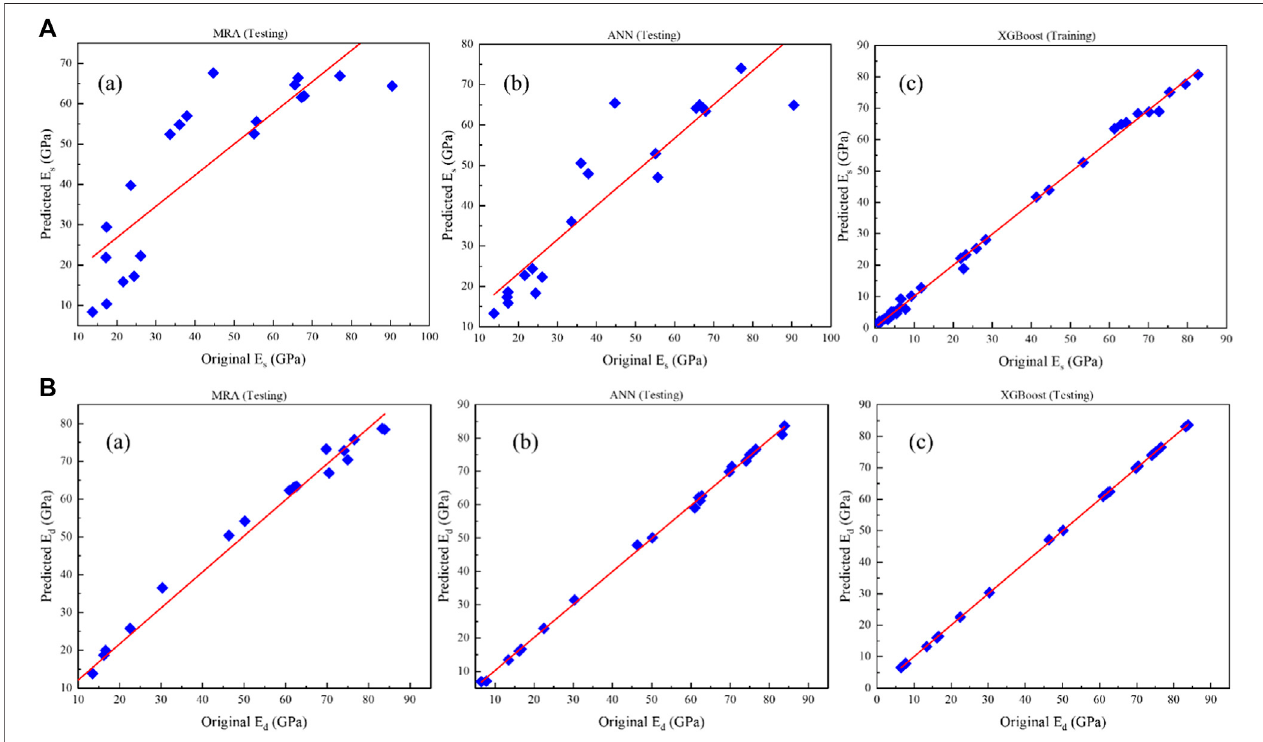
FIGURE 7 | Results of (A) E s and (B) E d prediction against original data in the testing stage: (a) MLR, (b) ANN, and (c) XGBoost.